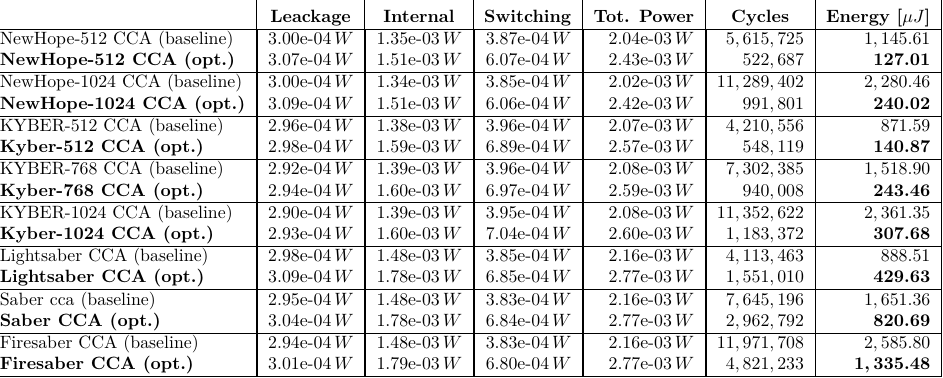
Table 9: Power and energy results for the ASIC synthesis (UMC 65 nm) Leackage Internal Switching Tot. Power